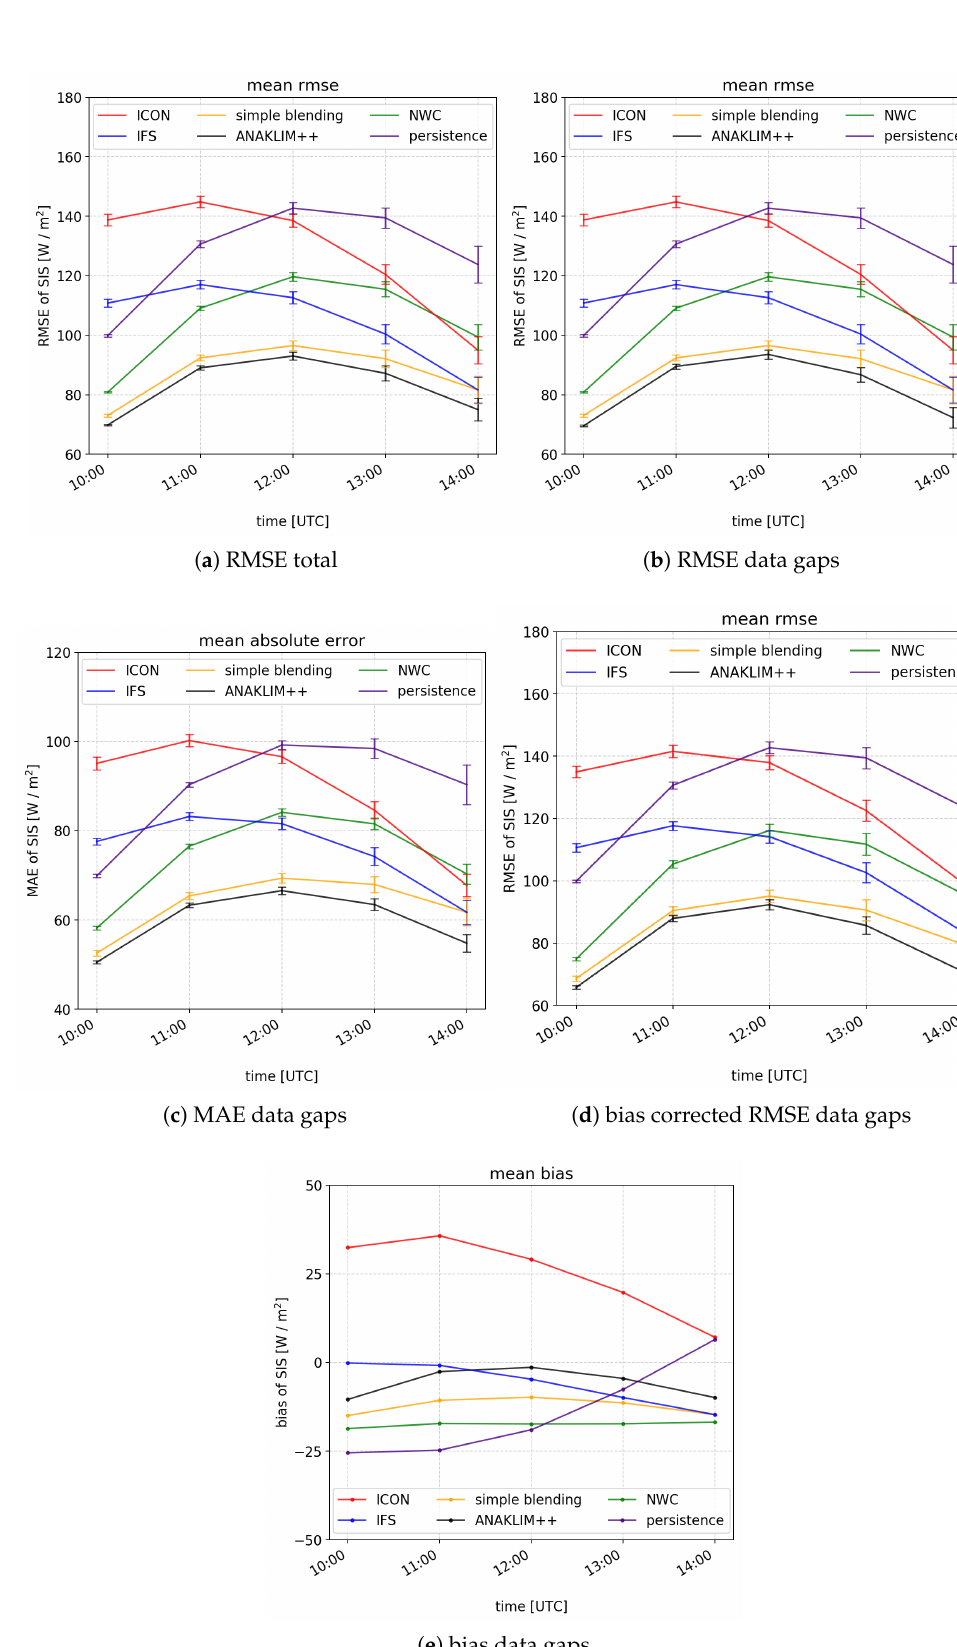
Figure 4. Mean error measures of all cases against day time for ( a ) RMSE (root mean square error) with whole NWC, ( b ) RMSE with gaps in NWC, ( c ) MAE (mean absolute error) with gaps, ( d ) bias corrected RMSE with gaps and ( e ) bias with gaps. The empirical variance is depicted by error bars for ( a – d ). The validation of SIS was performed with SARAH-2 data and the region of interest is